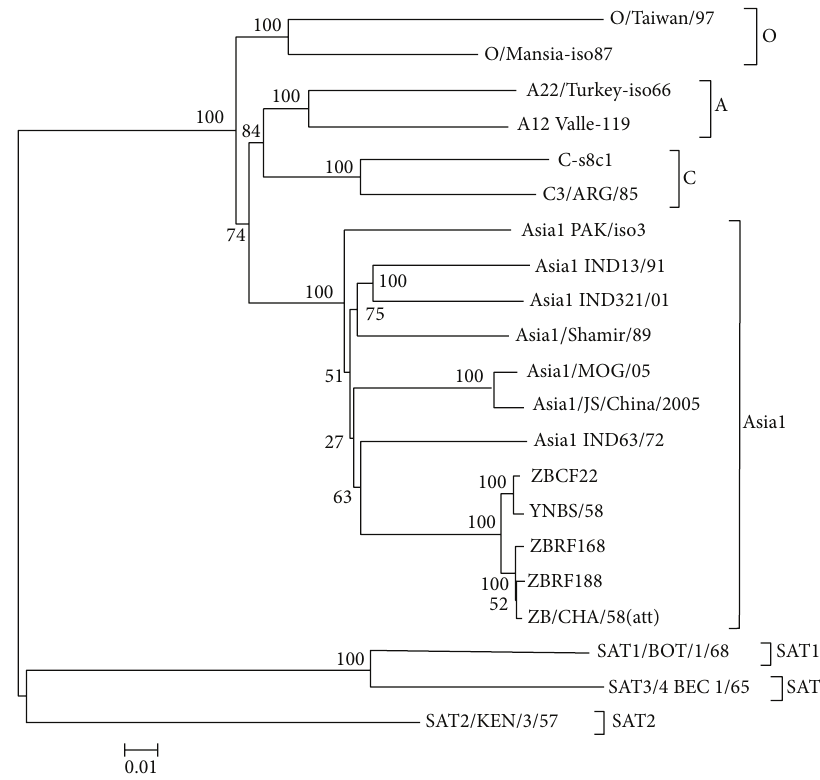
Figure 1: Phylogenetic analysis of the FMDV genome sequences. Phylogenetic tree was constructed by the neighbor-joining method by using MEGA 3.1, and bootstrap values were determined by 1,000 replicates. The GenBank accession numbers of 16 reference strains are listed as follows. O Taiwan/97(AY593835), O/Manisa-iso87(AY593823), A12 Valle strain-119(AY593752), A22 Turkey/65-iso66(AY593765), C1/C-s8cl(AJ133357), C3/Arg/85(AJ007347), SAT1 BOT/1/68(AY593845), SAT2/KEN/57(AY251473), SAT3/4 BEC 1/65(AY593853), Asia1 PAK/iso3(AY593795), Asia1 IND 13/91(DQ989312), Asia1 IND321/01(AY687333), Asia1/Shamir/89(JF739177), Asia1/MOG/05(EF614458), Asia1/JS/CHA/05(EF149009), Asia1/IND 63/72(AY304994), YNBS/58(AY390432), and